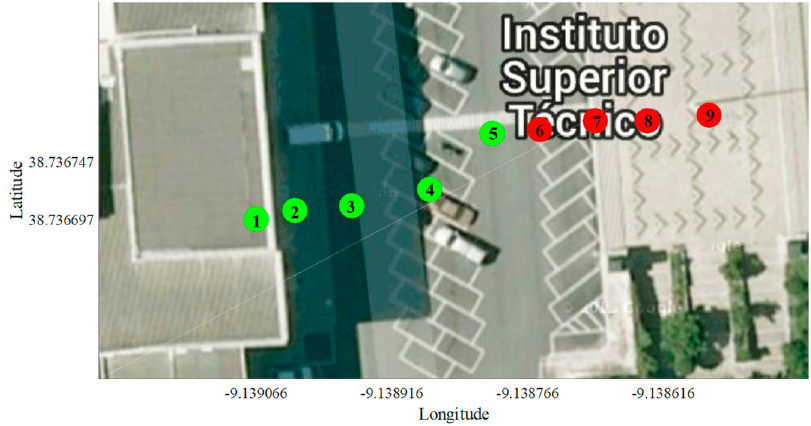
Figure 21. Case study C: Google Maps view with the results achieved.